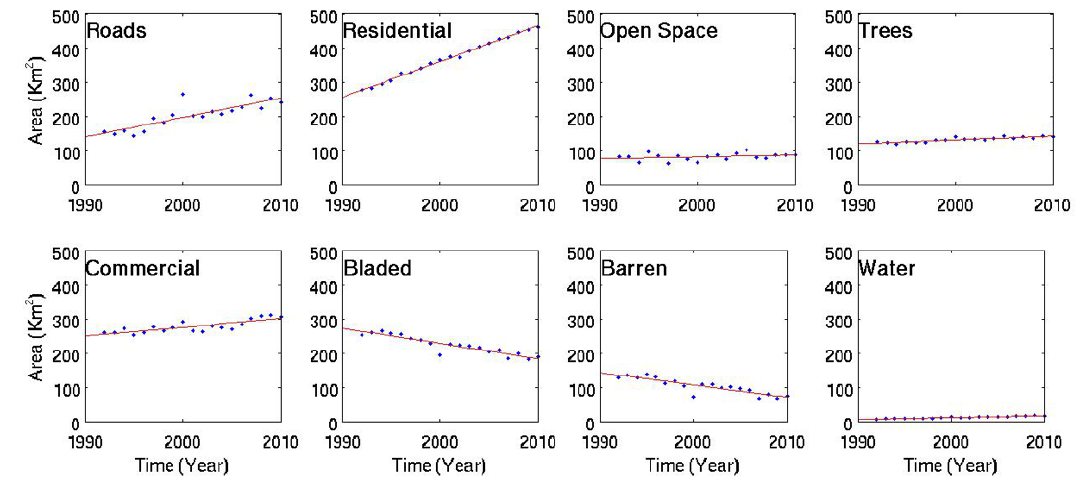
Figure 9. Time series plots of surface area of eight land cover classes in Las Vegas urban